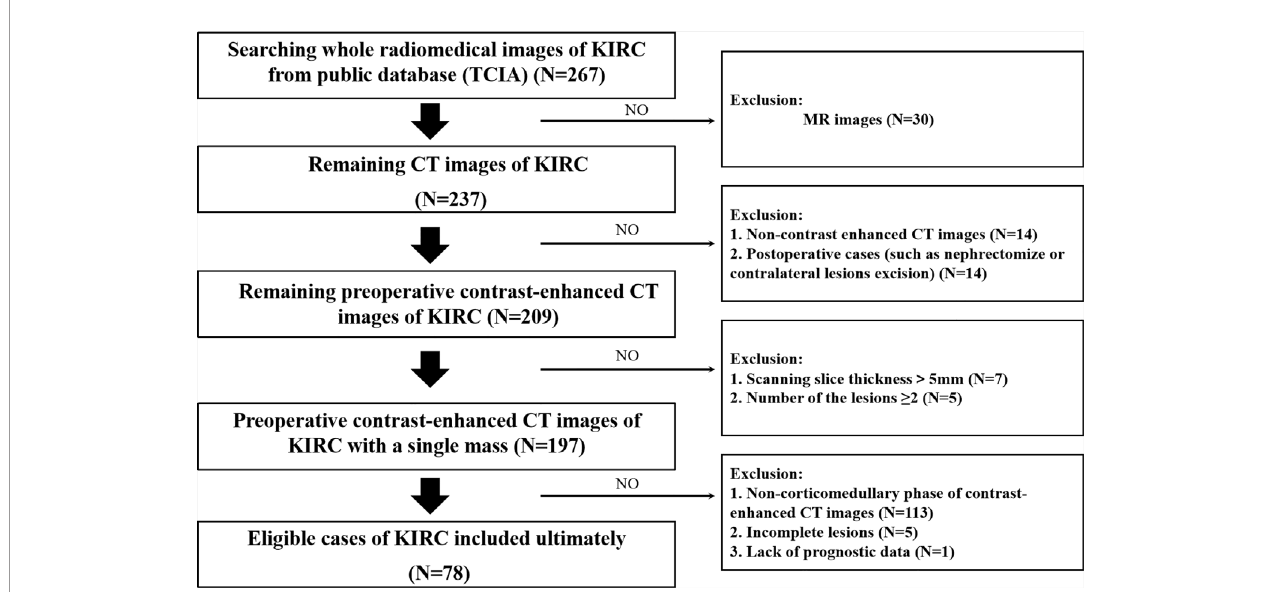
FIGURE 1 | Technology roadmap of this